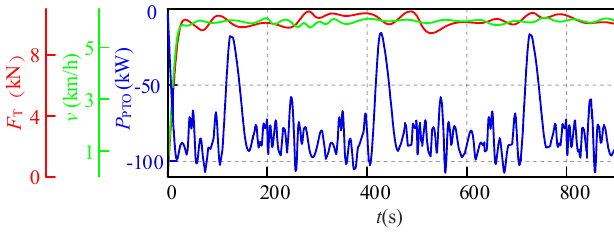
Figure 18. Harvest Figure 18. Harvest cycle.